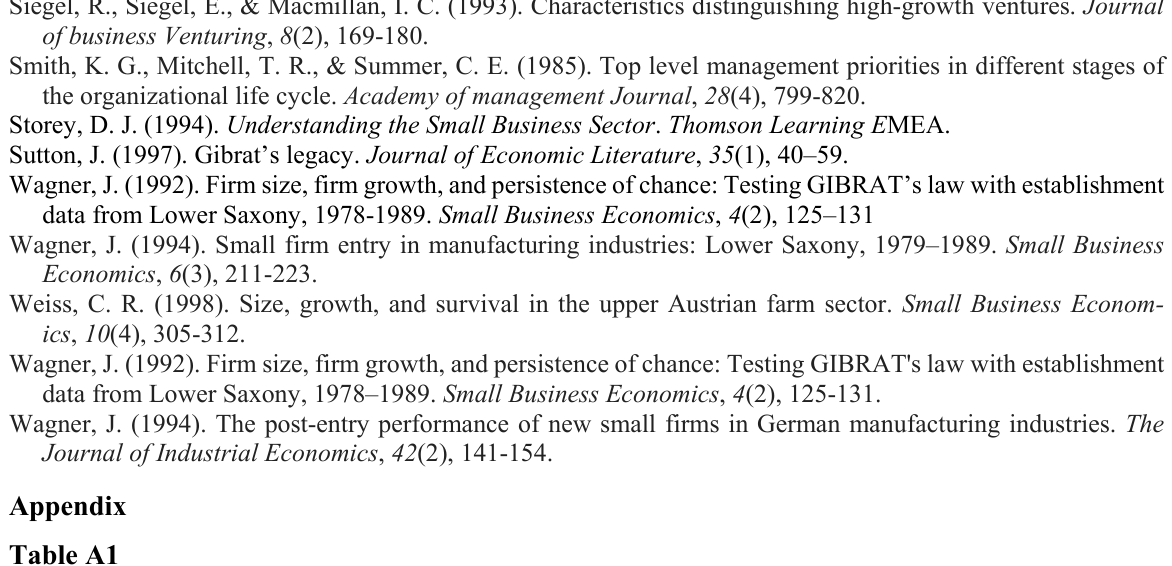
List of Industry Code and Industry Description ( Source : Aida, Bureau Van Dijk ) Code Industry